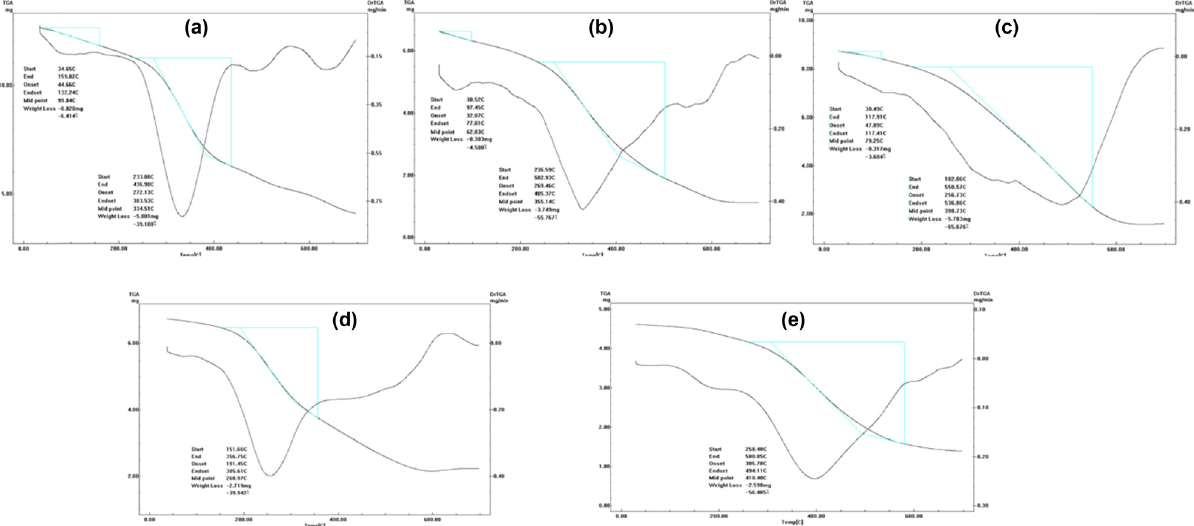
Figure 6: TGA – DrTGA curves of methoxy - diim free ligand ( a ) , cobalt ( II ) complex ( b ) , nickel ( II ) complex ( c ) , copper ( II ) complex ( d ) , and zinc ( II ) complex ( e ) .